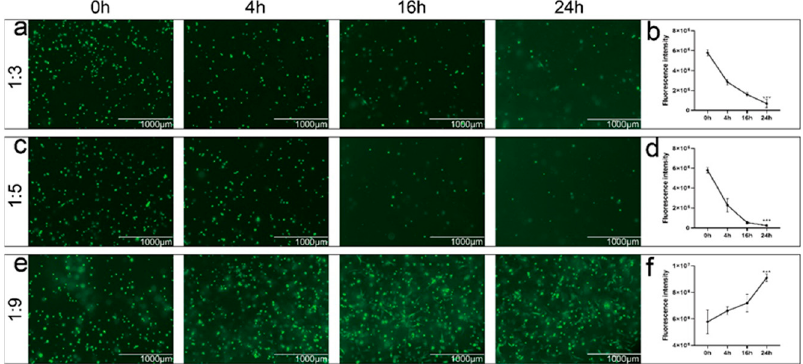
Figure 3. Cell viability measurement in hydrogel. ( a ) Fluorescence images at 0, 4, and 16 h after the hydrogel and cells are mixed and solidified with a mixing ratio of β –GP and CS of 1:3. ( b ) Quantitative chart of the fluorescence images at 0, 4, and 16 h after the hydrogel and cells are mixed and solidified with a mixing ratio of β –GP and CS of 1:3. ( c ) Fluorescence images at 0, 4, and 16 h after the hydrogel and cells are mixed and solidified with a mixing ratio of β –GP and CS of 1:5. ( d ) Quantitative chart of the fluorescence images at 0, 4, and 16 h after the hydrogel and cells are mixed and solidified with a mixing ratio of β –GP and CS of 1:5. ( e ) Fluorescence images at 0, 4, 16, and 24 h after the hydrogel and cells are mixed and solidified with a mixing ratio of β –GP and CS of 1:9. ( f ) Quantitative chart of the fluorescence images at 0, 4, and 16 h after the hydrogel and cells are mixed and solidified with a mixing ratio of β –GP and CS of 1:9. Randomly take 6 images of the cell culture system with different concentrations in each period and calculate the average value of the fluorescence intensity. Scale bars: a, c, e = 1000 μ m. Data are expressed as the mean ± SEM; n = 3, p < 0.001 ***.